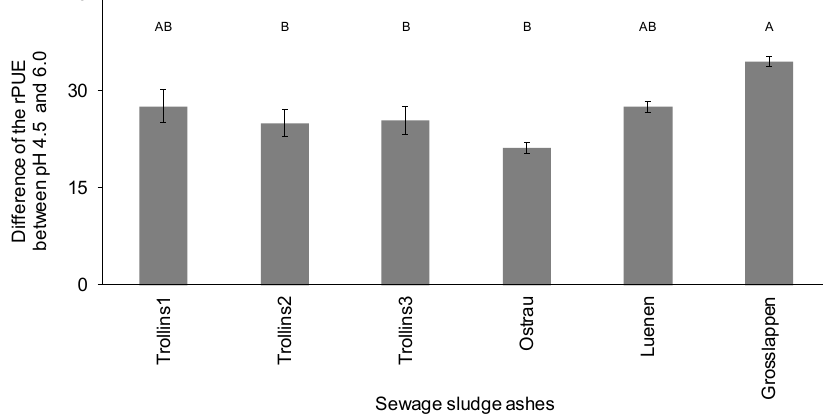
Figure 3. Difference of relative phosphorus use efficiency (rPUE) in percentage points between pH 4.5 and 6.0 for each sewage sludge ash (SSA). Different letters indicate differences between the SSAs (Tukey test, p < 0.05), and error bars indicate standard error of mean (n = 4).